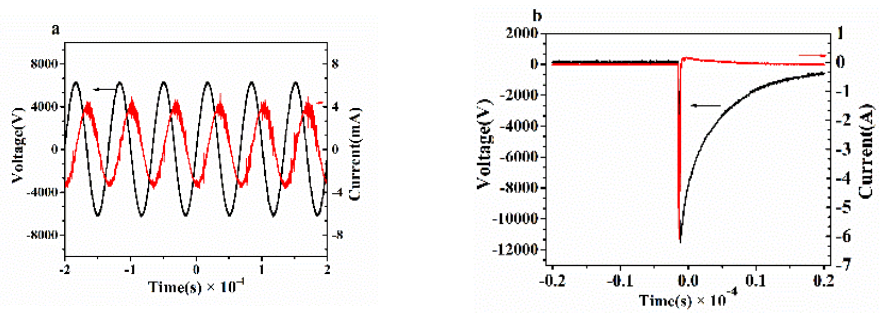
Figure 2. The typical I and V waveforms of two used powers ( a ) sinusoidal ac; ( b ) negative pulse.